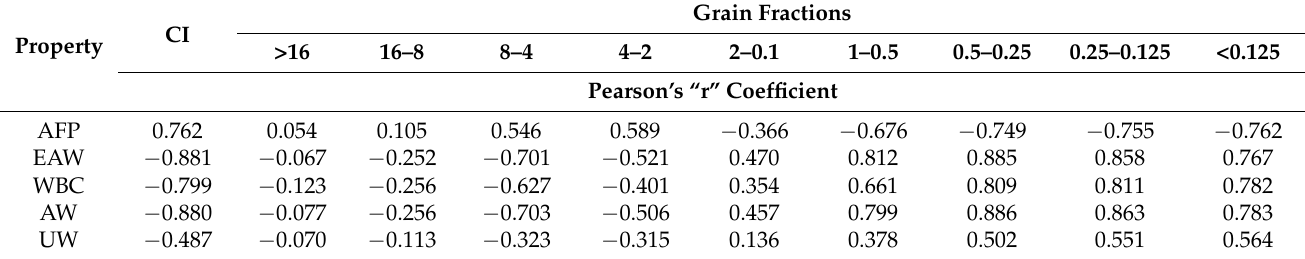
Table 4. Correlation matrix between granulometry and the air–water relations of tuffs